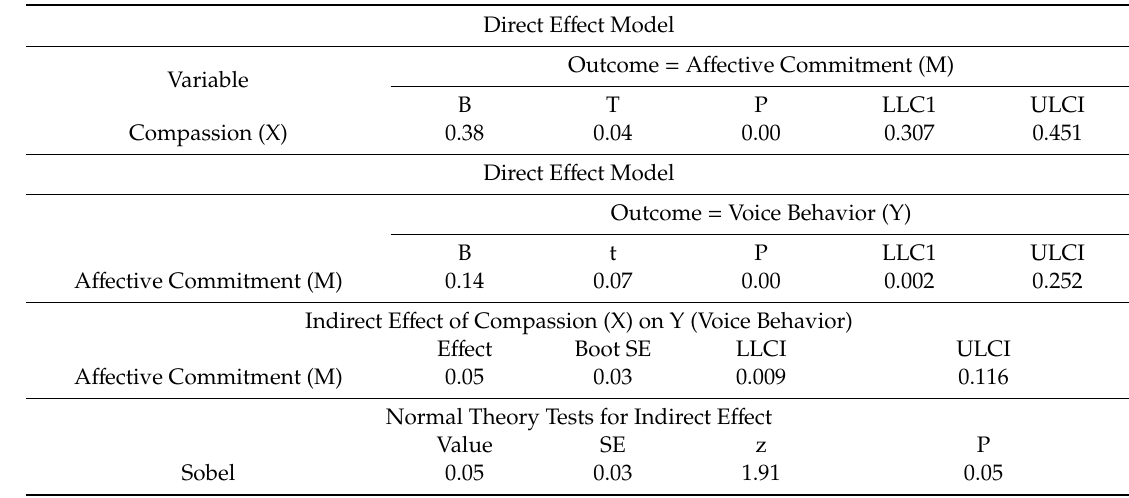
Table 4. Results of a simple mediation model regressing a ff ective commitment as